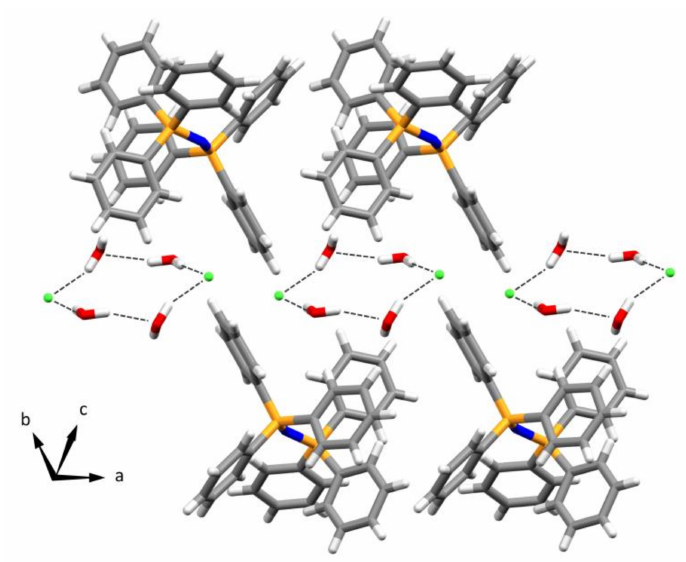
Figure 5. Crystal packing of 3 , showing the formation of hydrogen bonds between water molecules and chlorine atoms. This is shown in a capped sticks